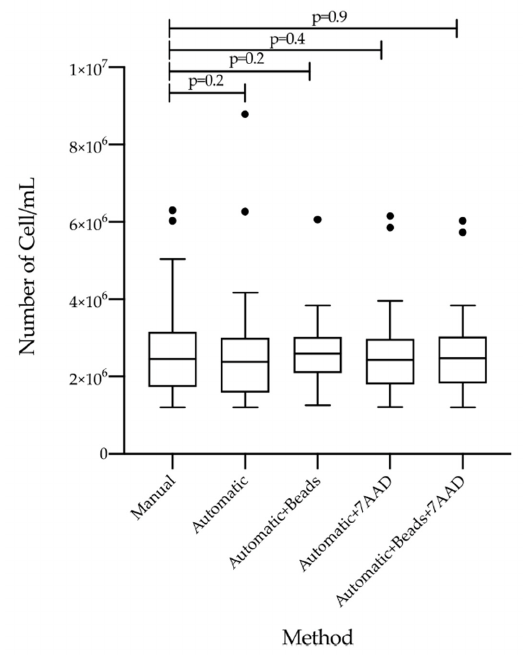
Figure 2. Comparison of five counting methods respect to the number of white blood cells. White blood cells were isolated from 28 mL peripheral blood samples of 90 patients with chronic myeloid leukemia (CML). Cells were enumerated using five different counting methods: the manual method, the automatic absolute measurement, the automatic assay using counting beads, the automatic protocol with 7-Aminoactinomycin D (7AAD) solution, and the automatic method based on the use of either counting beads and 7AAD. Cell counts, expressed as number of cells/mL solution, were investigated to determine the counting recovery efficiency. The number of cells was determined for each method and showed as Tukey-boxplots. Thick lines in each boxplot represent the median of number of cells/mL for each method. The dark dots indicate the outlier’s value. The student-paired t -test was used to test the difference between the five counting methods and p value below 0.05 was considered statistically significant.